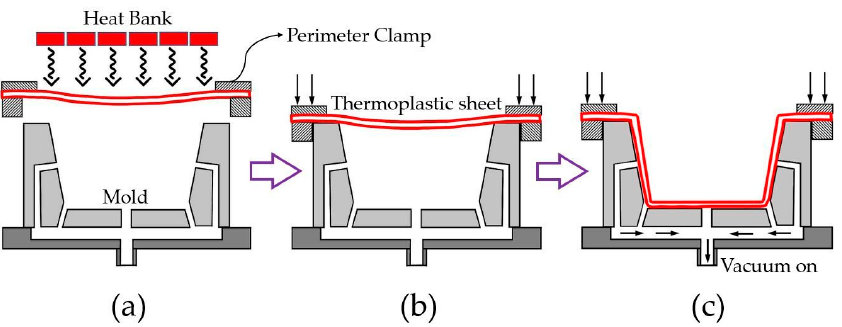
Figure 2. Schematic of basic vacuum thermoforming. ( a ) Heating; ( b ) sealing or pre-stretch; ( c ) form- ing and cooling [4].